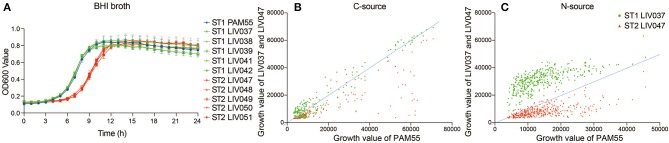
(A) Growth curve of L. ivanovii subsp. ivanovii strains in BHI broth. The growth of each strain was exhibited by different color as legend, bars represent the mean of five replicates mean ± SD. (B) Phenotype MicroArray data of L. ivanovii subsp. ivanovii strains in 192 carbon-sources. (C) Phenotype MicroArray data of L. ivanovii subsp. ivanovii strains in 384 nitrogen-sources. The growth values were the area under growth curve, and the dotted line represents the growth of reference strain PAM55.